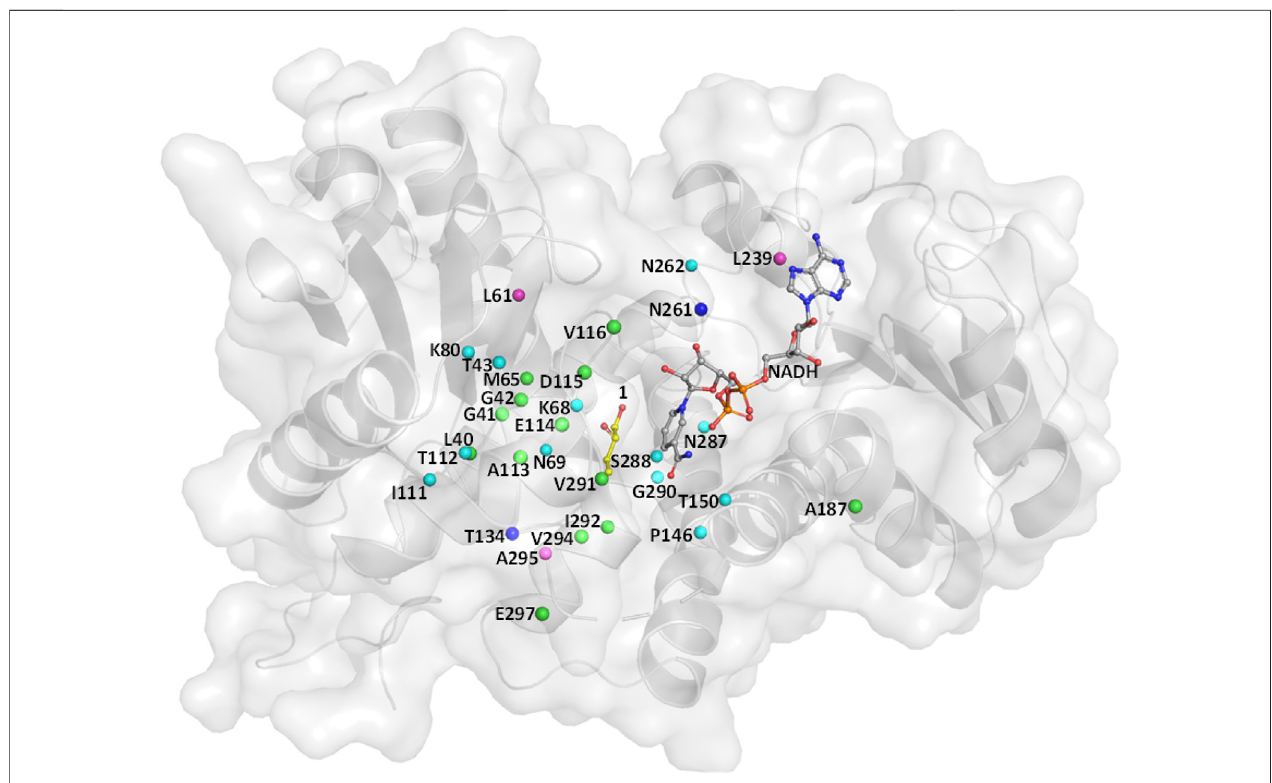
FIGURE 1 | Residues lining the substrate-binding pocket of Sp LeuDH (PDB ID: 3VPX). The sites marked in green, cyan, and blue are obtained from the three studies Abrahamson et al. (2012); Ye et al. (2015); Chen et al. (2019), respectively. The sites marked in magenta are found in this study.